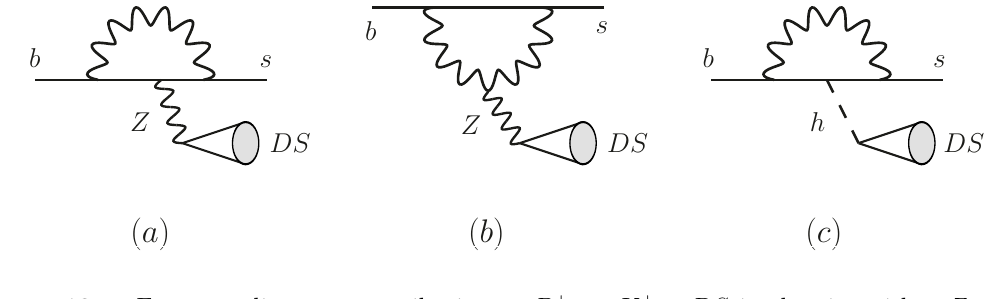
Figure 12 . Feynman diagrams contributing to B + → K + + DS in theories with a Z -portal (diagrams ( a ) and ( b ) ) and a Higgs portal (diagram ( c )